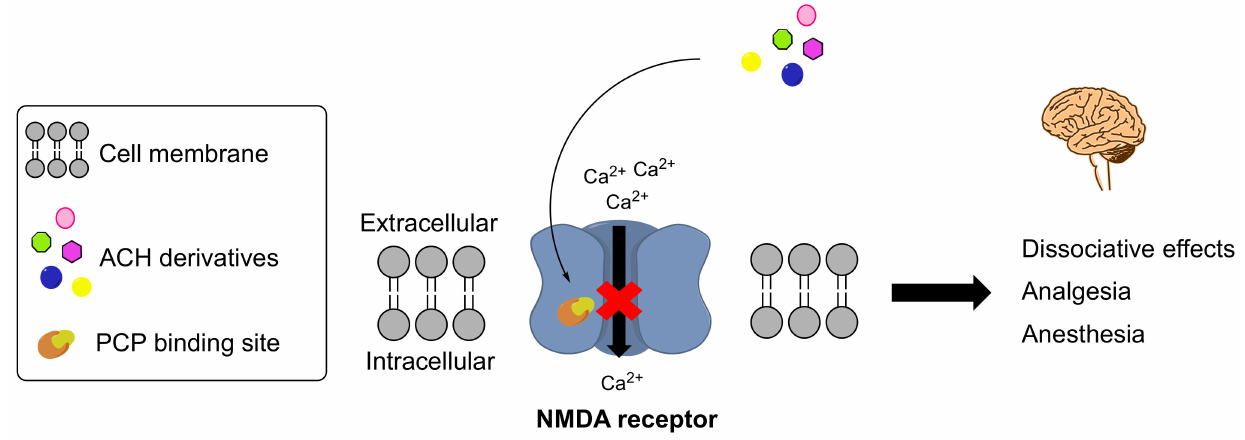
Figure 2. Mechanism of action of arylcyclohexylamine